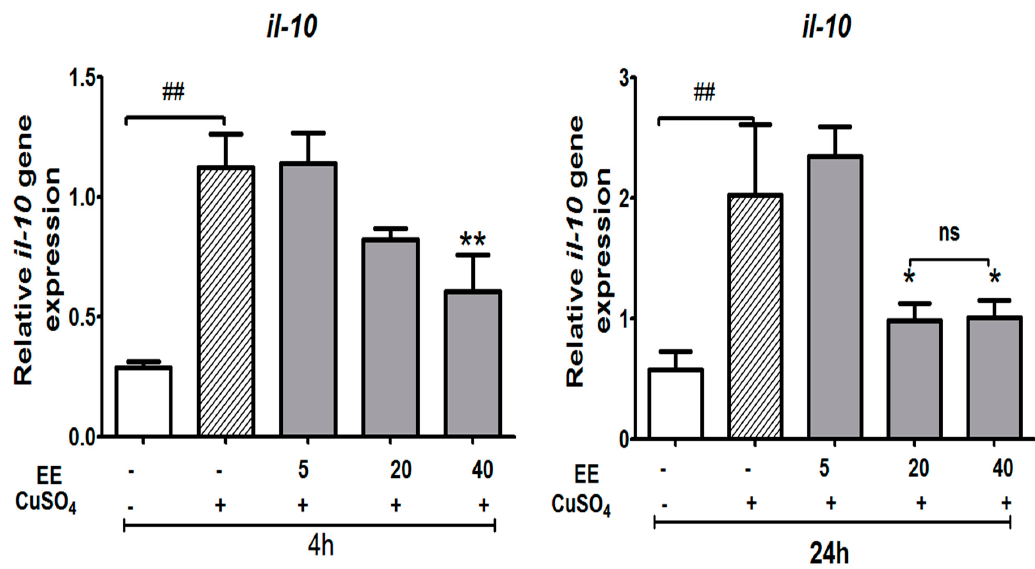
Figure 9. Relative expression of anti-inflammatory gene ( il-10) of zebrafish larvae after exposure to CuSO 4 and treatment with the ethanol extract (EE) of C. cyrtophyllum Turcz at different doses. The zebrafish larvae were exposed to EE for 1 h and to CuSO 4 10 µ M for 4 and 24 h. After 4 or 24 h,